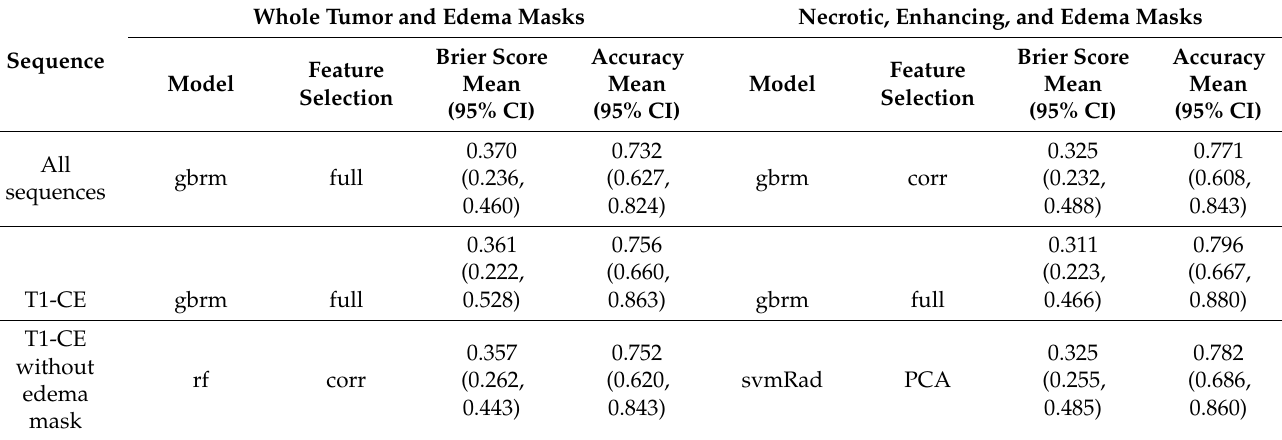
Table 4. Predictive performance of both pipelines for all sequence